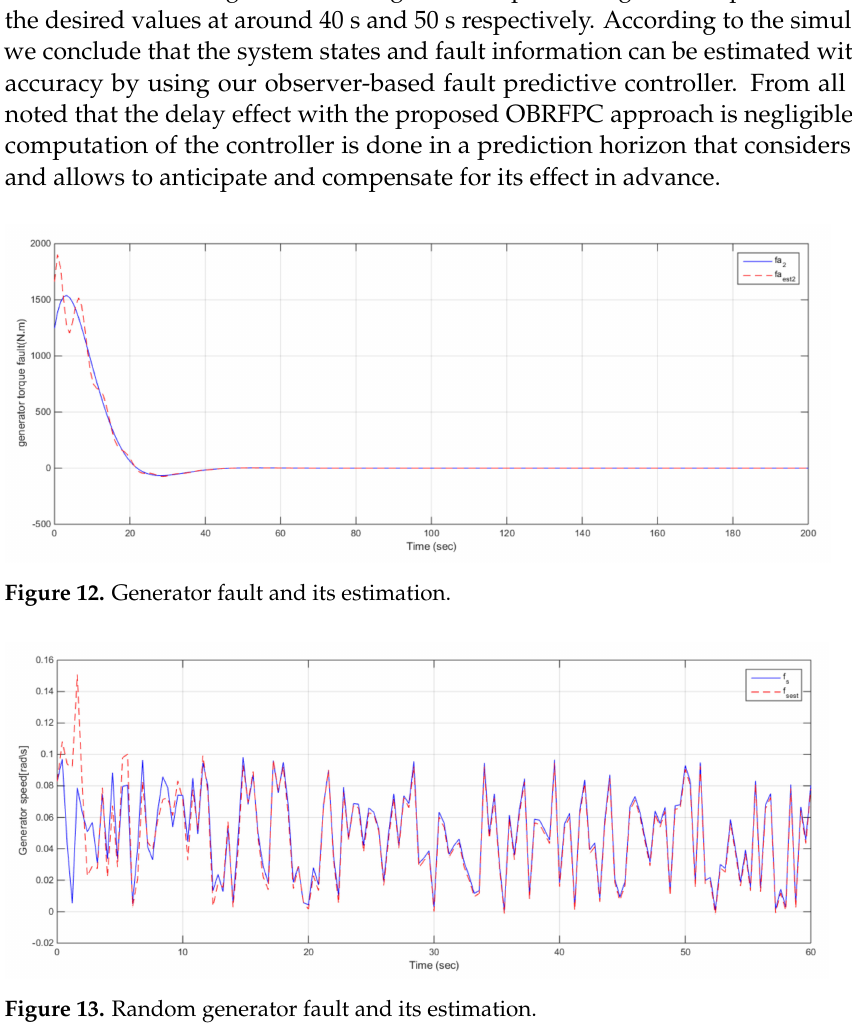
Figure 13. Random generator fault and its